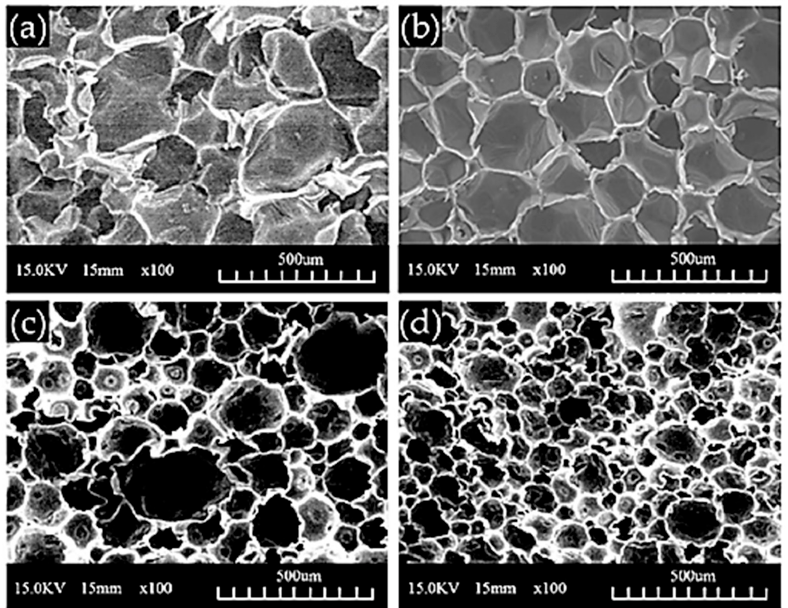
Figure 10. SEM images of polyurethane foam samples were prepared with reaction times of ( a ) 15; ( b ) 90; ( c ) 180; and ( d ) 300 min [88].